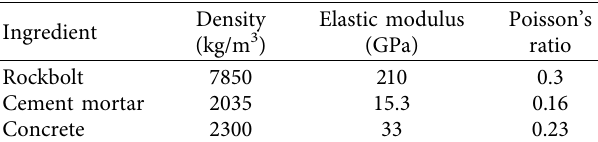
Table 2: Material properties of the rock bolt, concrete, and cement